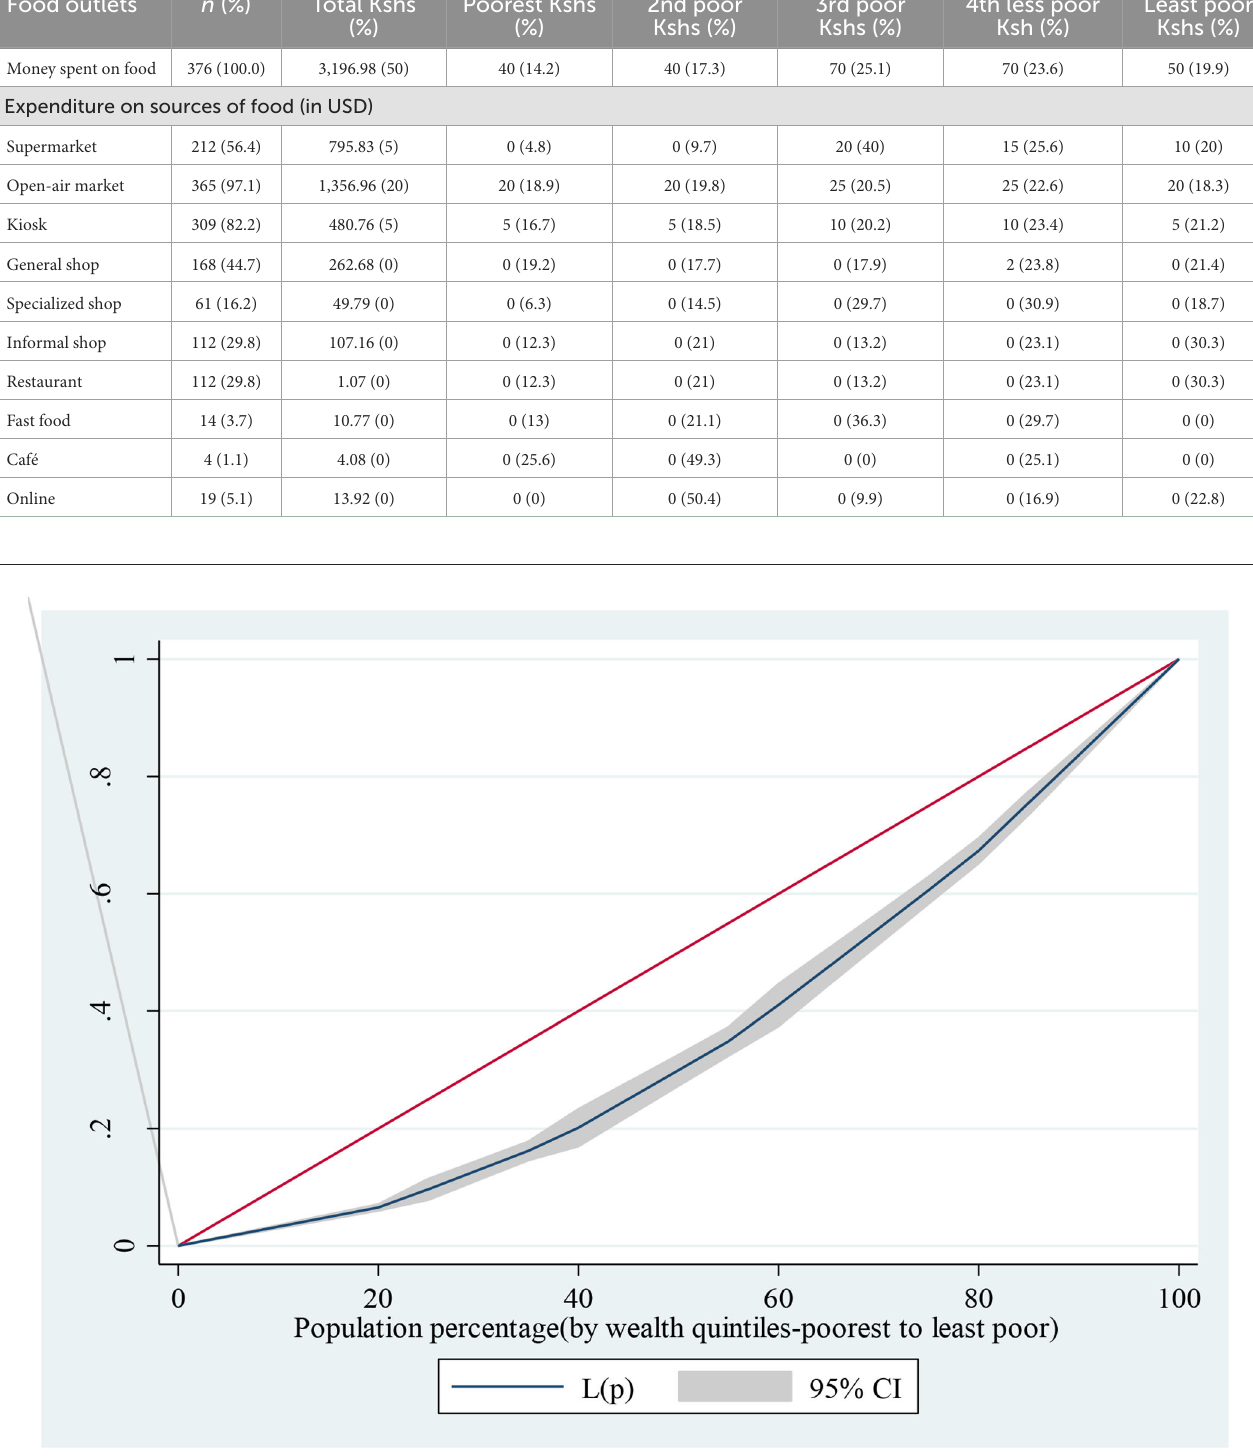
and expenditure of various sources of foods which will imply that interventions should be targeted to individuals in each socioeconomic group. Wealthier households are known to